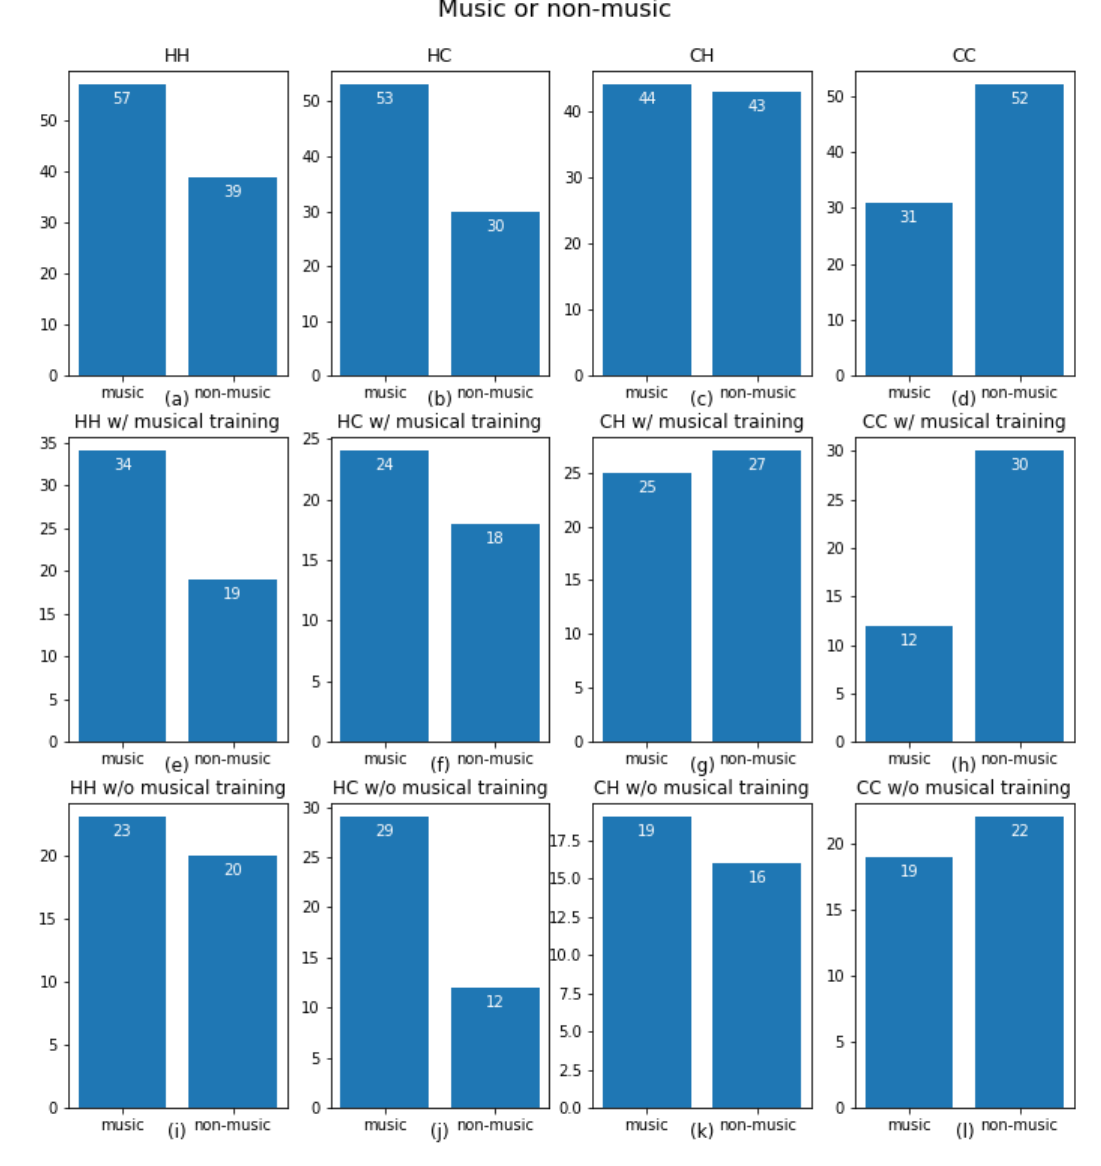
Figure 2. Number of participants in the considered groups: whole group ( a – d ), with musical training ( e – h ), and without musical training ( i – l ), that perceived what they heard as music or non-music. HH = music composed and performed by a human; HC = music composed by a human and performed by a machine; CH = music composed by a machine and performed by a human; CC = music composed and performed by a machine; w/ = with; w/o =